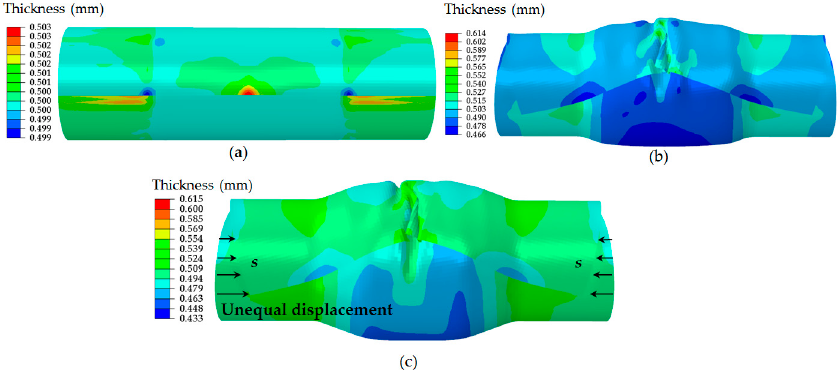
Figure 9. Hydroforming lapping blank with free ends ( a ) p = 2.0 MPa; ( b ) p = 5.0 MPa; ( c ) p = 9.0 MPa.